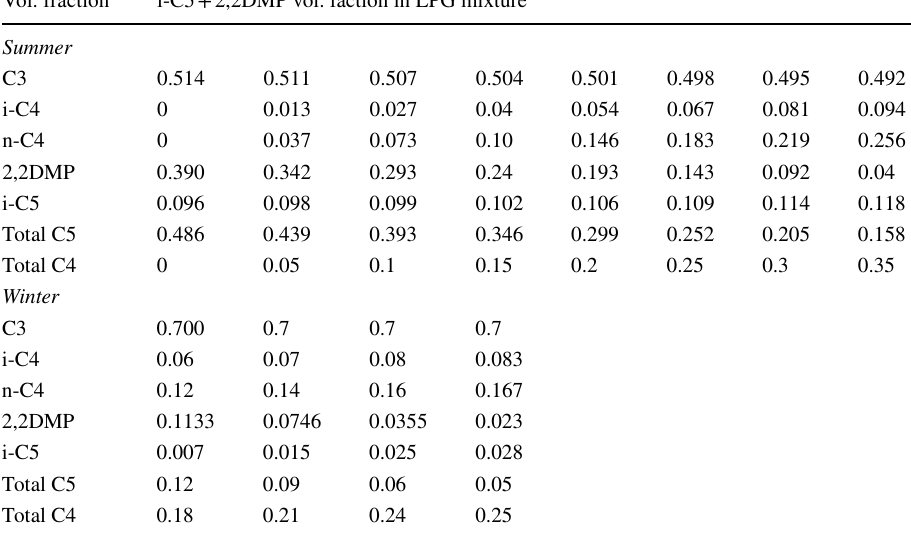
Vol. fraction i-C5 + 2,2DMP vol. faction in LPG mixture